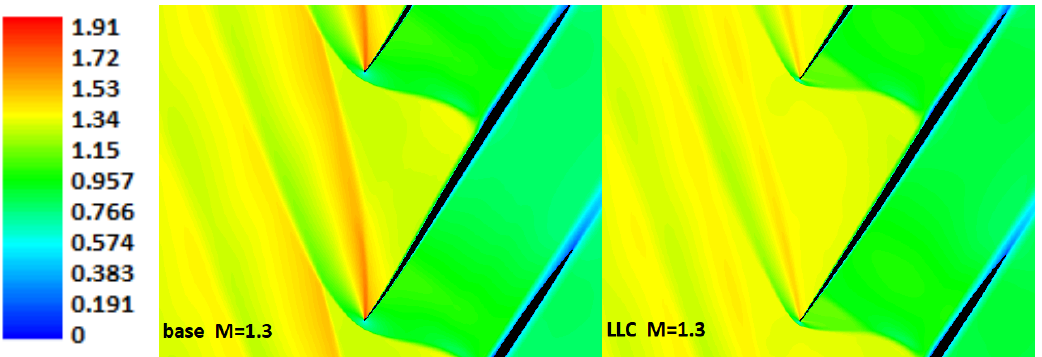
Figure 10. Front fraction shapes ( a – c ) and isentropic Mach number ( d – f ) of LLC profiles.